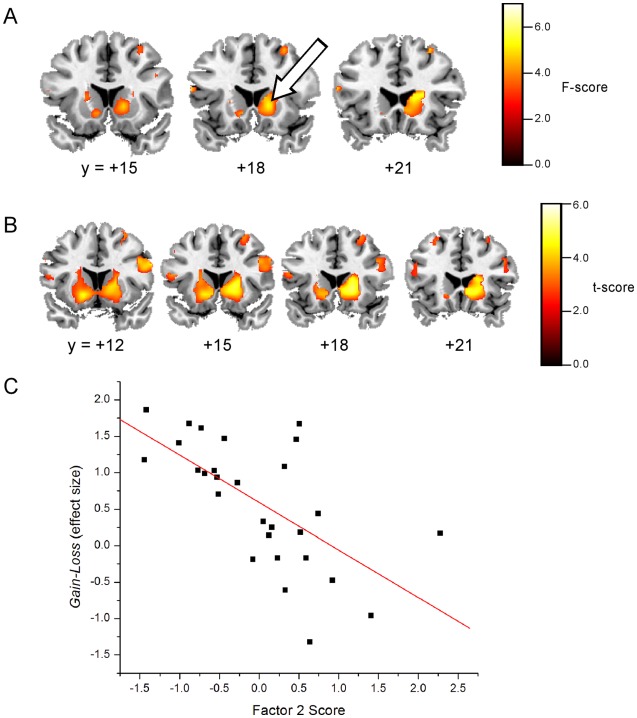

A. Statistical parametric F-maps (coronal slices; y-dimension shown) of the one-way between-groups ANOVA multiple regression analysis of Factor 2 scores versus Gain-Loss contrast.Block white arrow points to the right dorsal caudate cluster that overlaps with the right dorsal caudate cluster shown in Figure 4, panel A. B. Statistical parametric t-maps (coronal slices; y-dimension shown) for the post hoc FCD group multiple regression analysis of Factor 2 scores versus Gain-Loss contrast. Threshold was set at q<0.05 FDR corrected; minimum cluster size k = 10 voxels (masked with the Reward mask). C. Plot of the Gain-Loss effect size versus Factor 2 score regression analysis, with each Gain-Loss contrast value being the mean value in a 5 mm radius sphere centered at peak voxel x,y,z  = 18,18,0 for each subject in the FCD group. The correlation coefficient of the fitted line was R = −0.641 (p = 0.0002 uncorrected).